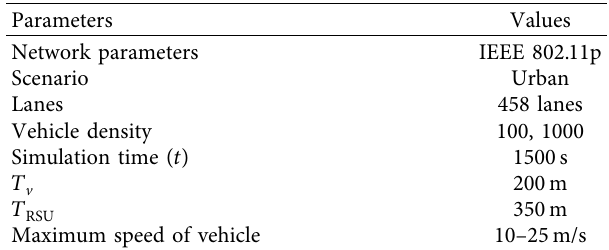
Table 2: Simulation parameters.